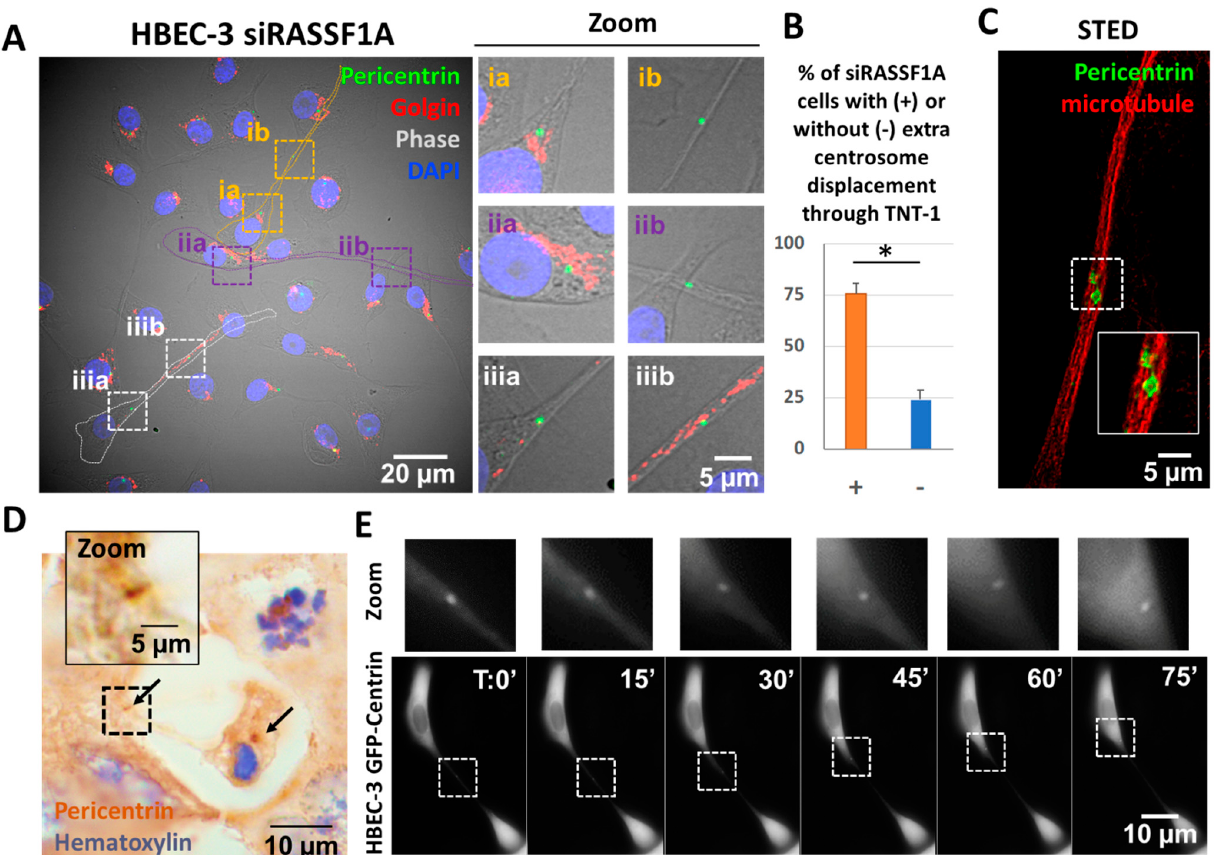
Figure 3. The presence and movement of centrosome within TNTs-1. ( A ) Representative images, with zoom focusing on three cells with TNT-1 (i, ii, iii), showing centrosome at the base of TNT-1 (ia, iia, iiia) or in the TNT (ib, iib, iii b). Dashed squares indicate the region used for the zoom. ( B ) Quantification of centrosome displacement through TNT-1. n > 70 cells. The cells were scored as (+) if extra centrosome was positioned within TNT-1. Data are represented as the mean ± SEM from at least three individual experiments. Statistical significance was calculated and p value are indicated by asterisks: * p < 0.05. ( C ) STED super-resolution microscopy reveals ring shape pericentrin staining using microtubule to move through TNT. Dashed white square indicates the region used for the zoom ( D ) Representative immunohistochemistry staining of pericentrin in paraffin-embedded NSCLC tumor section. White arrows indicate centrosome position. Dashed black square indicates the region used for the zoom. Black arrows show centrosome localization. ( E ) Montage of time-lapse imaging of EGFP-centrin transfected HBEC-3 cells showing centrosome movement through TNT-1. The Centrin2-RFP signal is presented as green, but the brightness and contrast were adjusted to identify the Centrin signal in the black and white background. Dashed white square indicates the region used for the